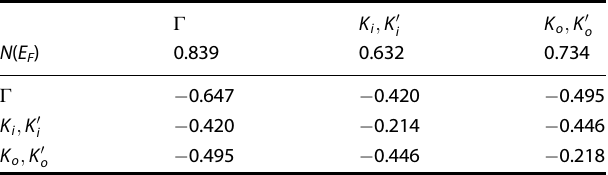
Table 2. Same as in Table 3, but for spin fl uctuations induced coupling.